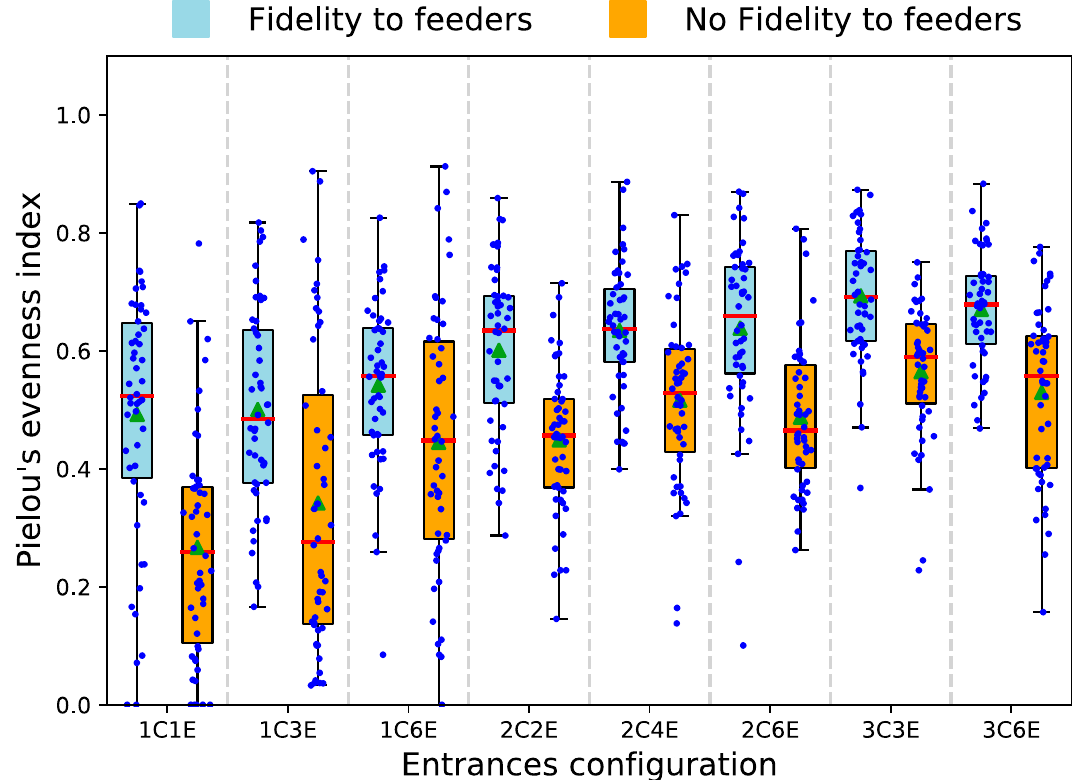
Figure 5. Influence of the nest entrances configuration (n = 50 simulations for each configuration) on the distribution of foragers among eight food sources. Distribution of the Pielou’s evenness index at the end of the simulations for different entrance configurations. We evaluated the impact of ant fidelity to the first encountered food source by simulating foragers moving with a memory bias (blue boxplot), or without it (orange boxplots). Green triangles indicate the mean, red lines indicate the median and circles indicate outliers.